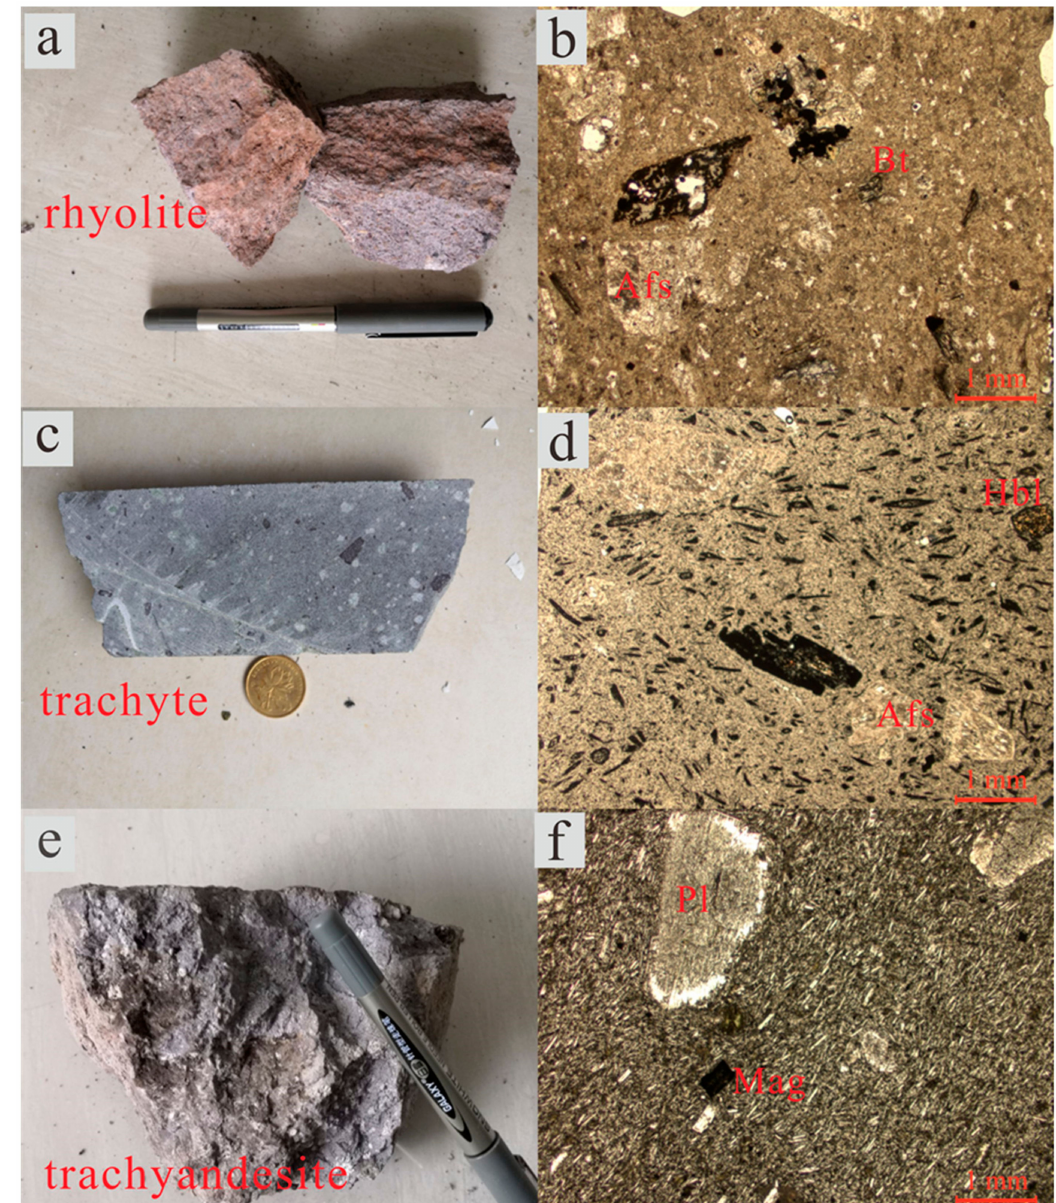
Figure 3. Photographs of rock hand specimens ( a , c , e ) and photomicrographs ( b , d , f ) of Shimaoshan Group volcanic rocks. Abbreviations: Hbl = Hornblende; Pl = plagioclase; Afs = Alkaline feldspar; Mag = magnetite, Bt =